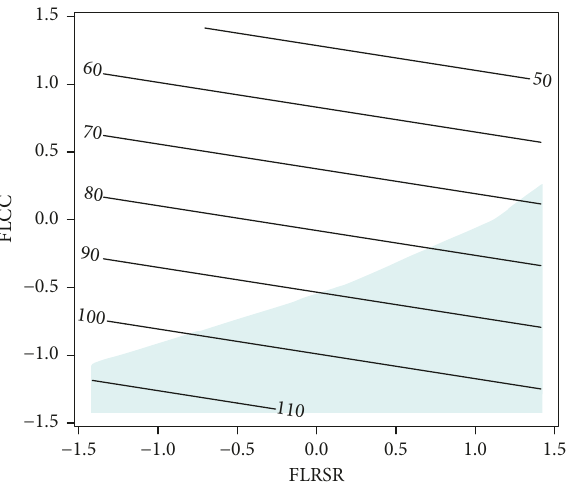
Figure 11: Contour map of consistency (for the contour map of uniformity 1 as the boundary, the line on blue background in above figure represents the consistency whose uniformity of rubber distribution is smaller than 1, and the line on white background represents the consistency whose uniformity of rubber distribution is not smaller than